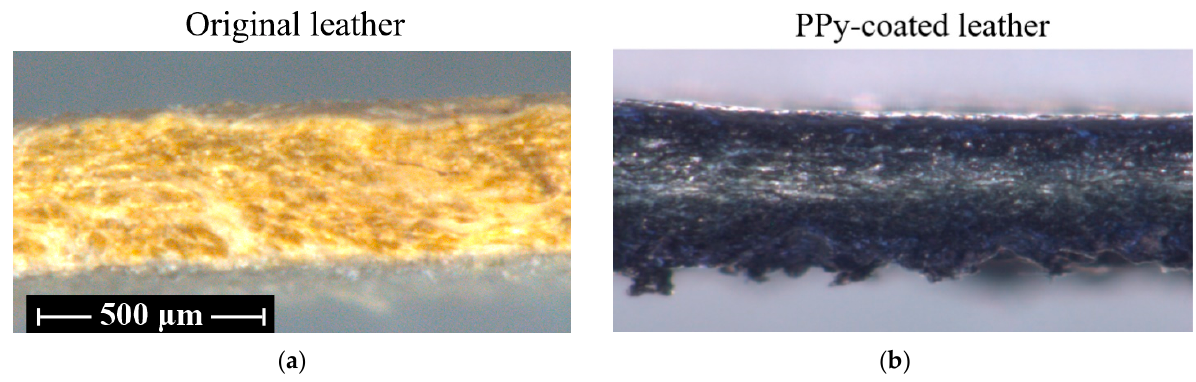
Figure 5. Cross-sectional optical microscopic images of ( a ) leather before and ( b ) after coating with polypyrrole in the presence of PVP and crystal violet .